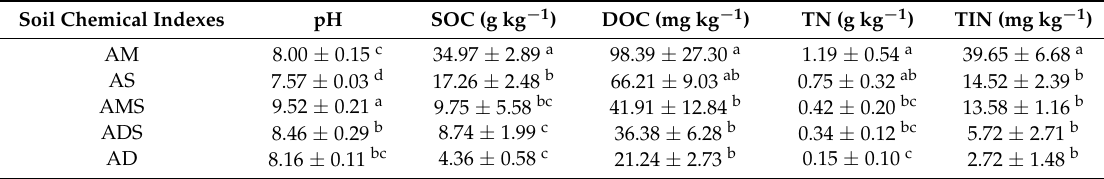
Table 1. The soil chemical characteristics of alpine grasslands in the Tibetan Plateau.